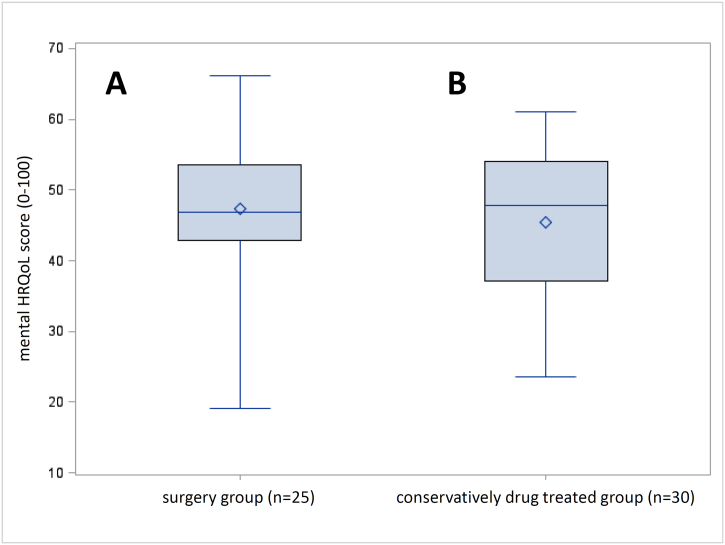
Boxplot representation of the mental sum scale after surgical (A) and drug therapy (B).